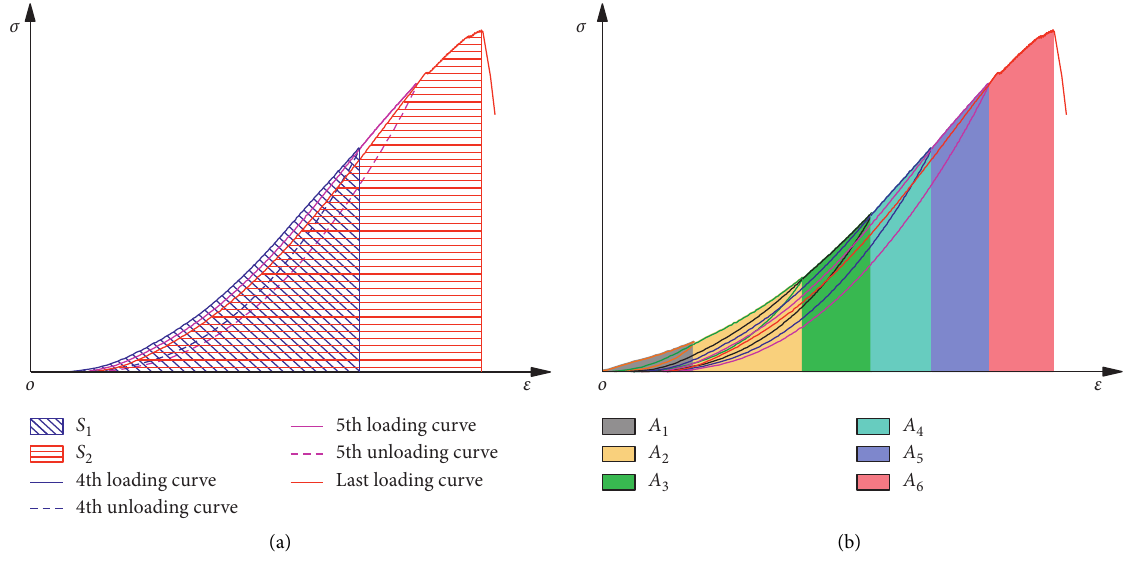
Figure 3: Schematic diagram for calculating input energy density in cyclic loading-unloading test. (a) Approach 1. (b) Approach